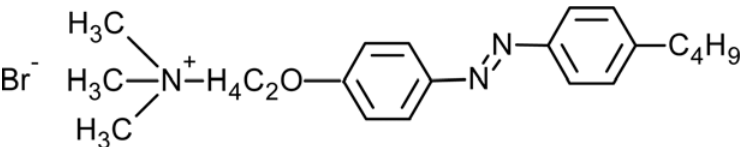
Figure 44. Chemical formula of